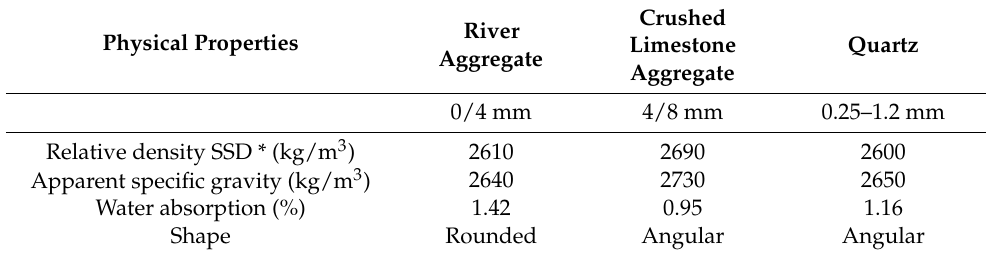
Figure 4. EDS spectrometry of cathode ray tube glass.